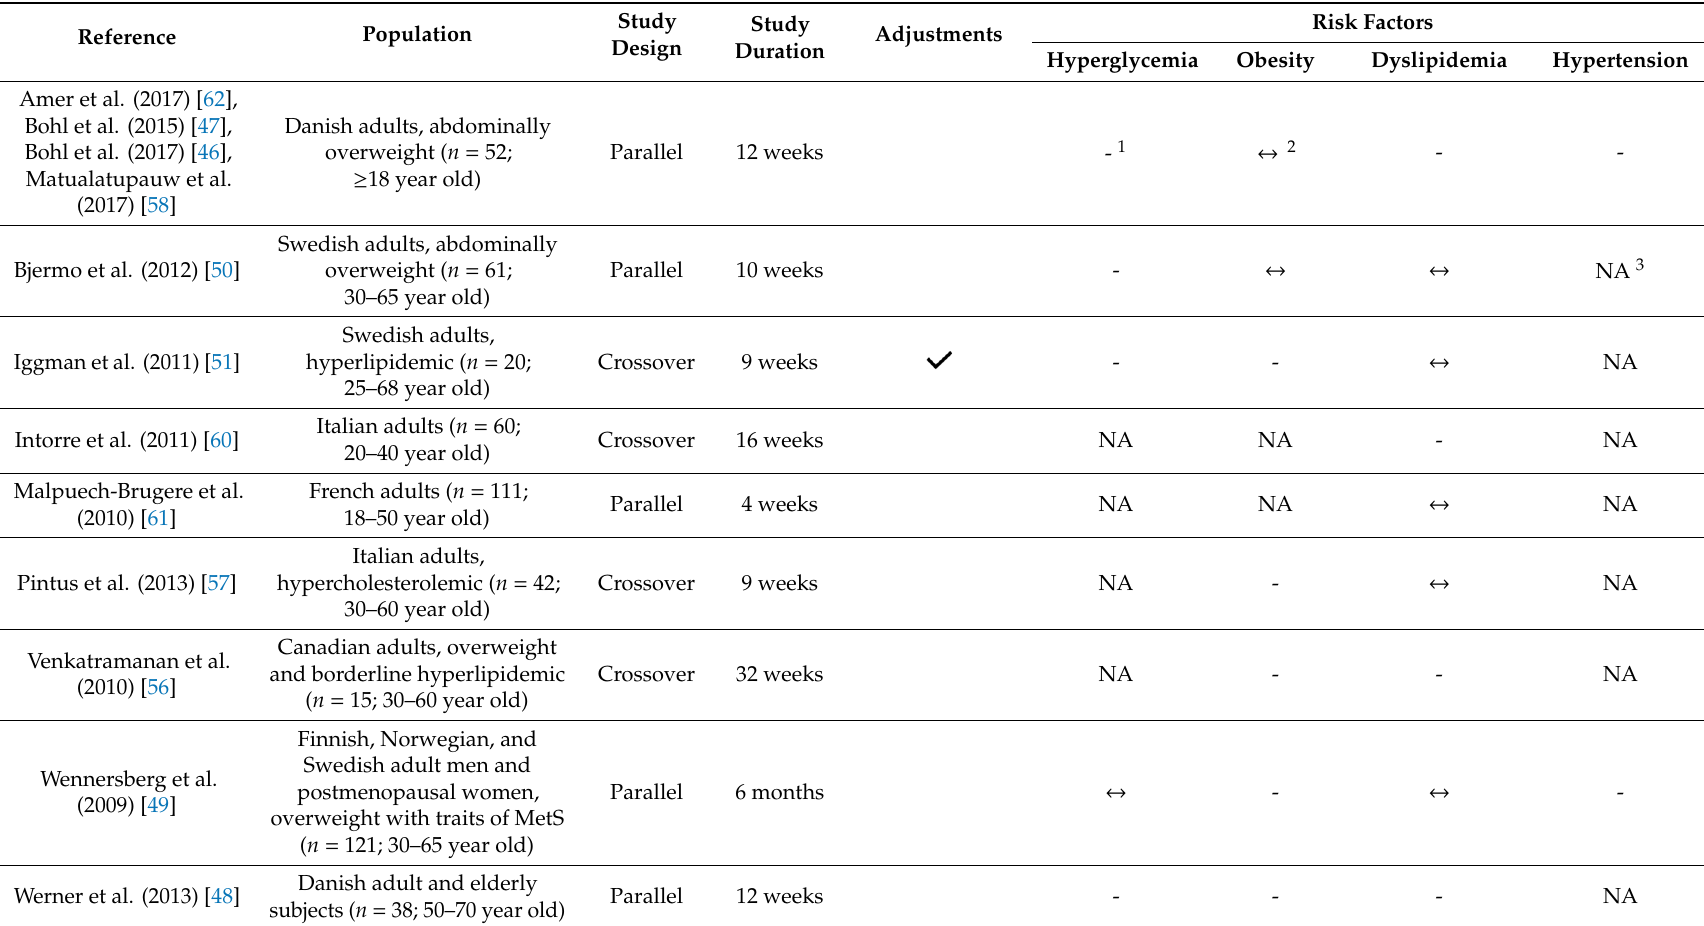
Table 3. Summary of clinical evidence on the e ff ect of the intake of dairy-derived saturated fatty acids on metabolic syndrome risk.